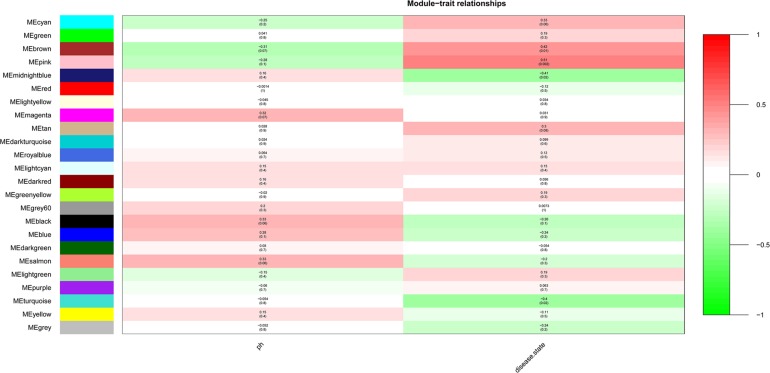
Module-trait relationships. Stage indicated bipolar disorder (BD) and non-BD.